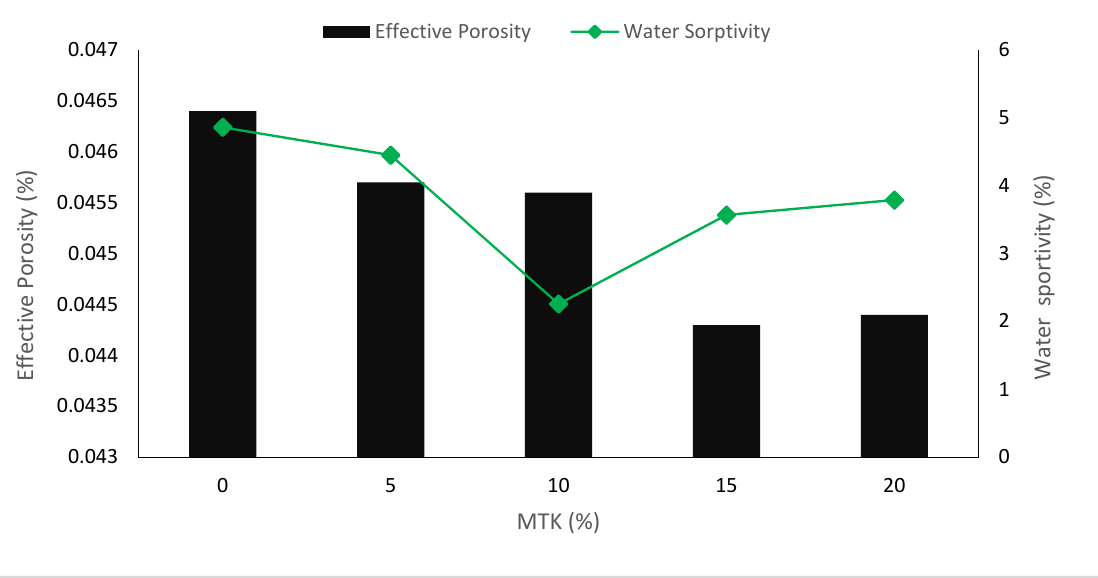
Figure 13. Porosity and water sportively [92] .